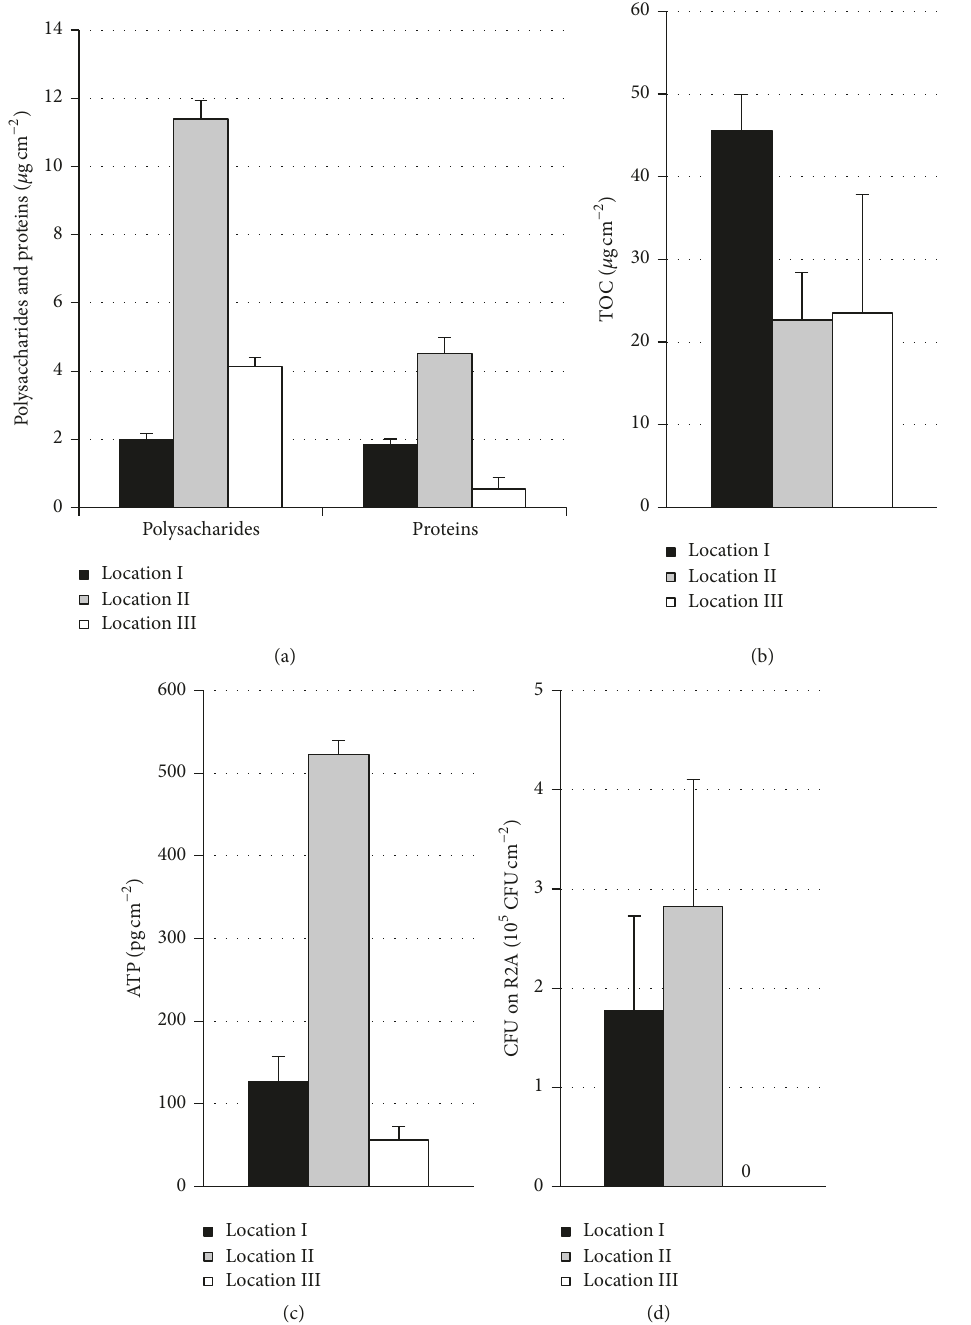
Figure 5: Fouling characterization from membrane and spacer samples from three RO locations studied. From (a)–(d), polysaccharides and proteins, total organic carbon, adenosine triphosphate, and colony-forming units on R2A